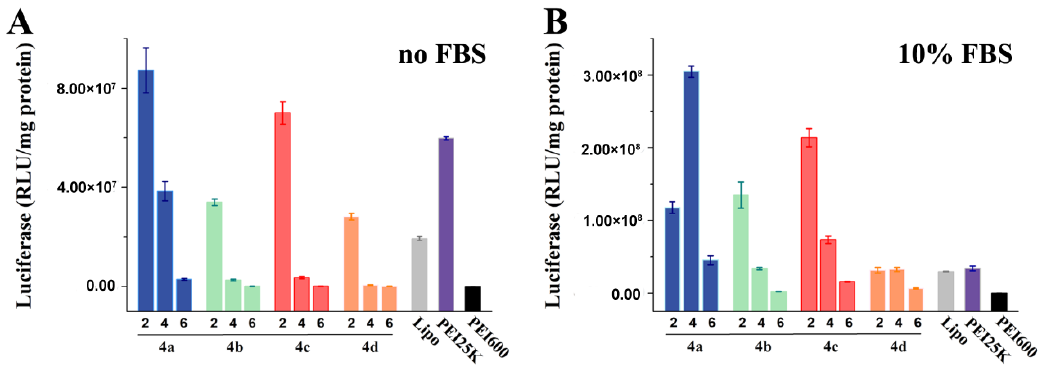
Figure 3. Luciferase gene expression transfected by polyplexes at different weight ratios: 2, 4, and 6 in comparison with Lipofectamine 2000, PEI 600 ( w / w = 6, N/P = 28.7) and 25 KDa PEI ( w / w = 1.4, N/P = 10) in human human cervix carcinoma cell lines (HeLa) in the absence of serum ( A ) and in the presence of 10% serum ( B ). Data are represented by mean ± S.D. ( n = 3).